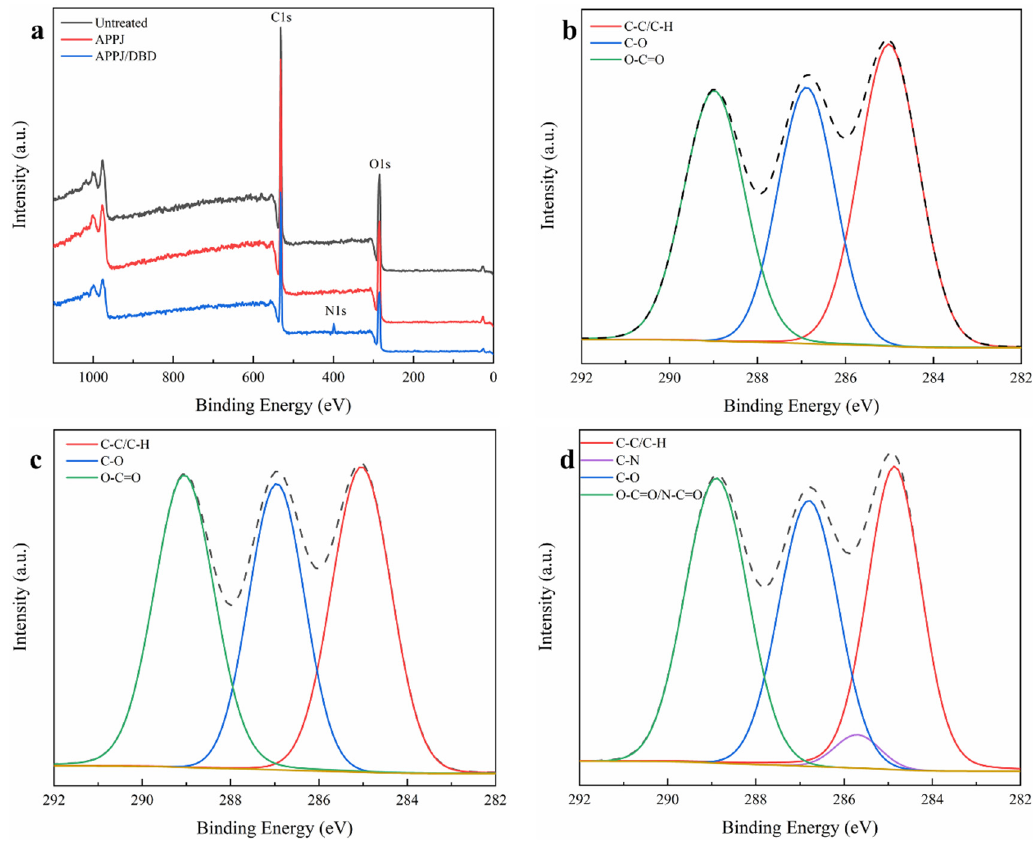
Figure 7. ( a ) Survey scan spectra of untreated, APPJ ‐ treated and APPJ/DBD ‐ treated PLA nanofibers; examples of high resolution C1 s curve fitting of untreated ( b ), APPJ ‐ treated ( c ) and APPJ/DBD ‐ treated ( d ) PLA nanofibers.